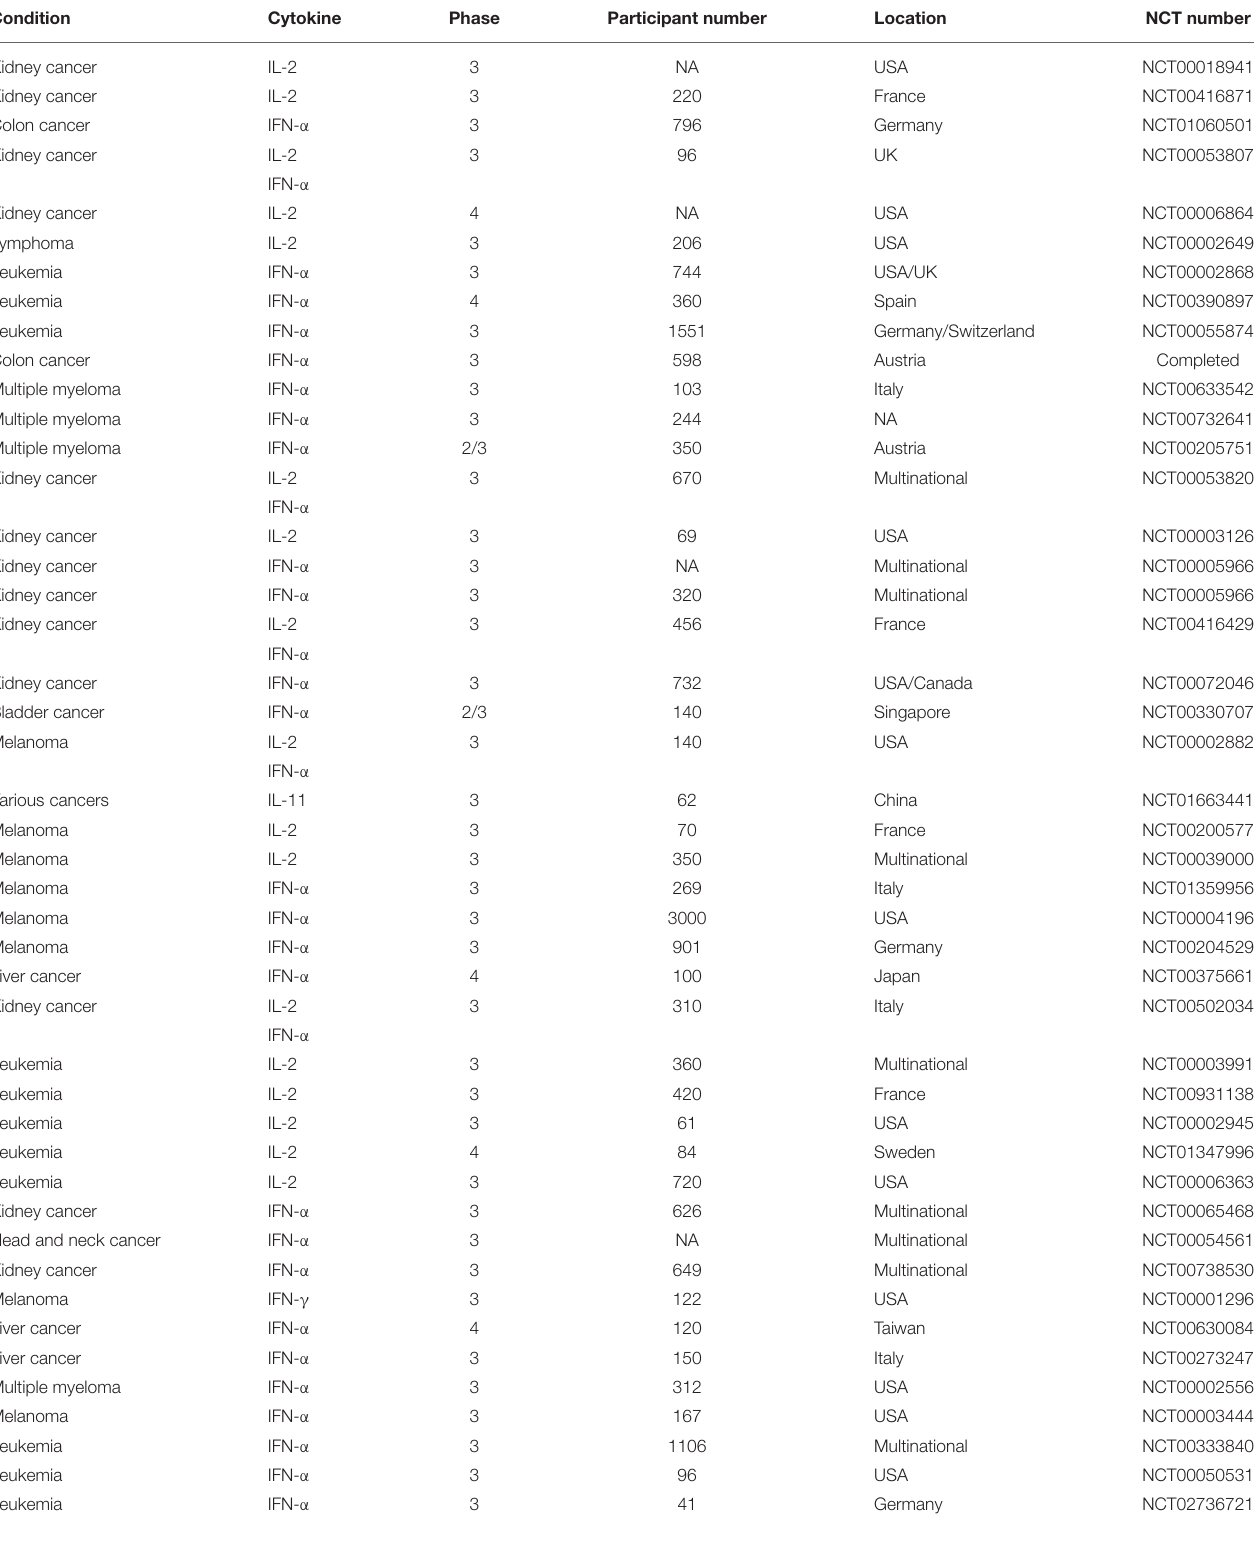
TABLE 1 | Completed clinical trials (phases 3 and 4) respecting cytokine-based immunotherapy for treatment of human cancers registered in ClinicalTrials.gov (May